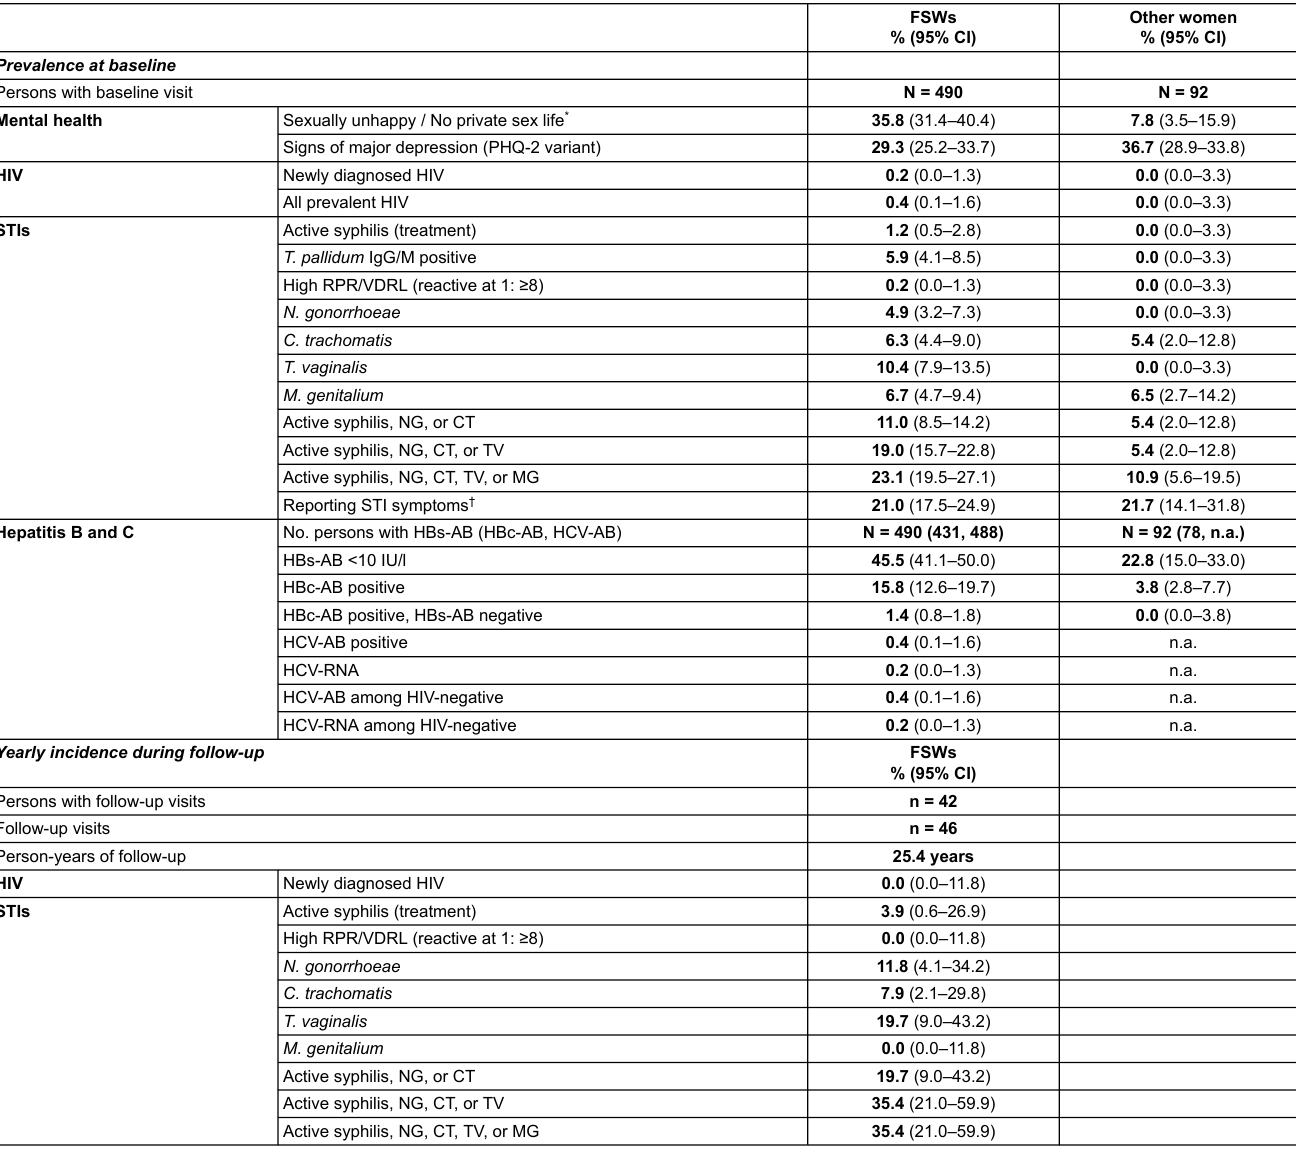
Table 2: Clinical outcomes. Mental health, HIV, STIs, hepatitis B and C, percentages with 95% confidence